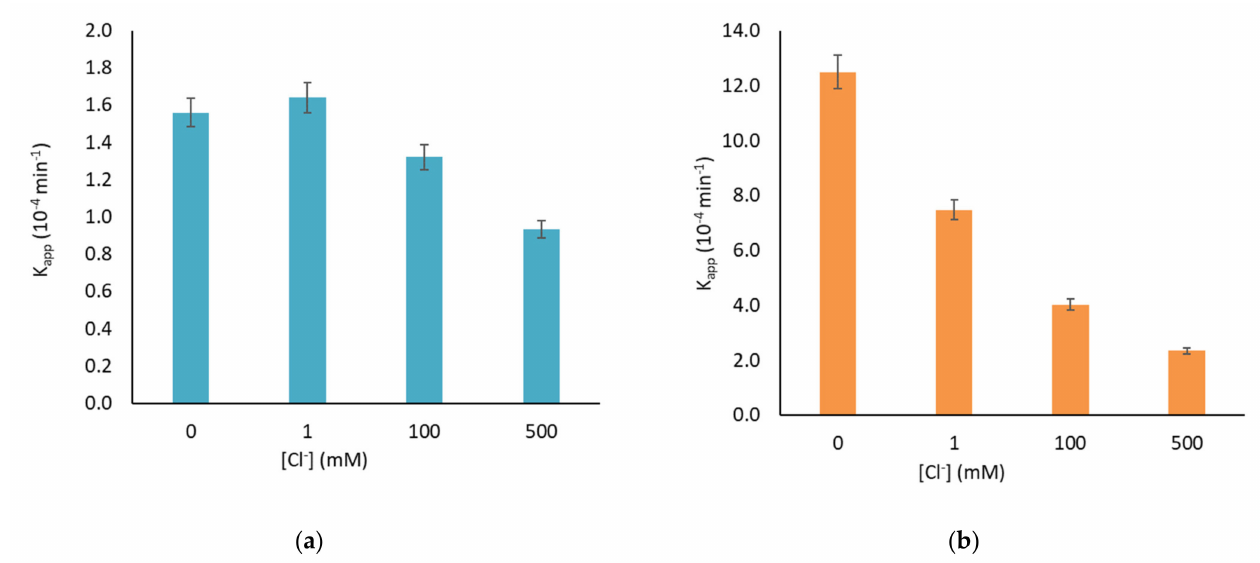
Figure 4. Pseudo-first order kinetic constants of the reactant removal process performed in solutions of 40 mg dm − 3 of DEP, 0.1 M NaClO 4 , and different chloride concentration. ( a ) Applied potential: 0.2 V; ( b ) applied potential: 1.8 V.